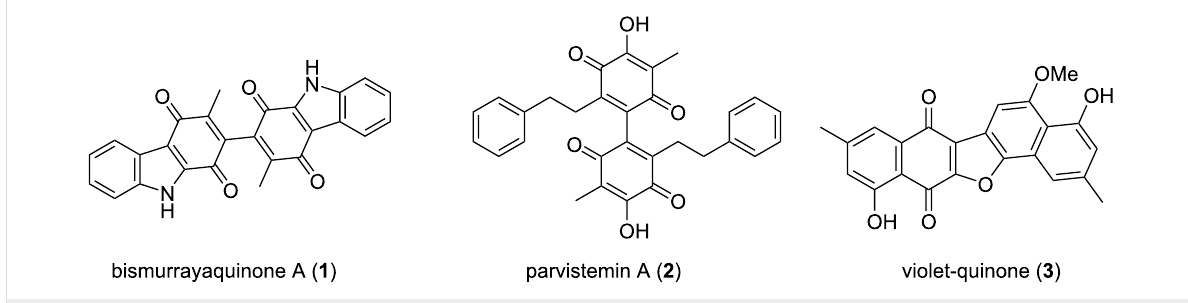
Figure 1: Selected natural products synthesized via oxidative